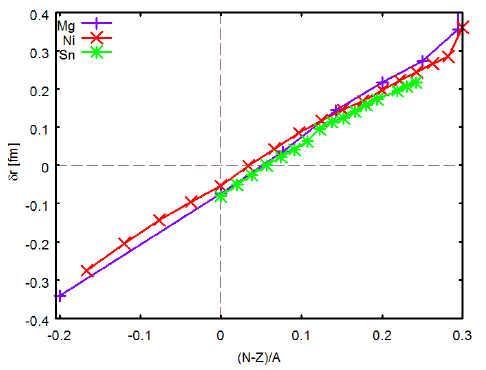
(cid:2) (cid:4) r 2 (cid:5) − n